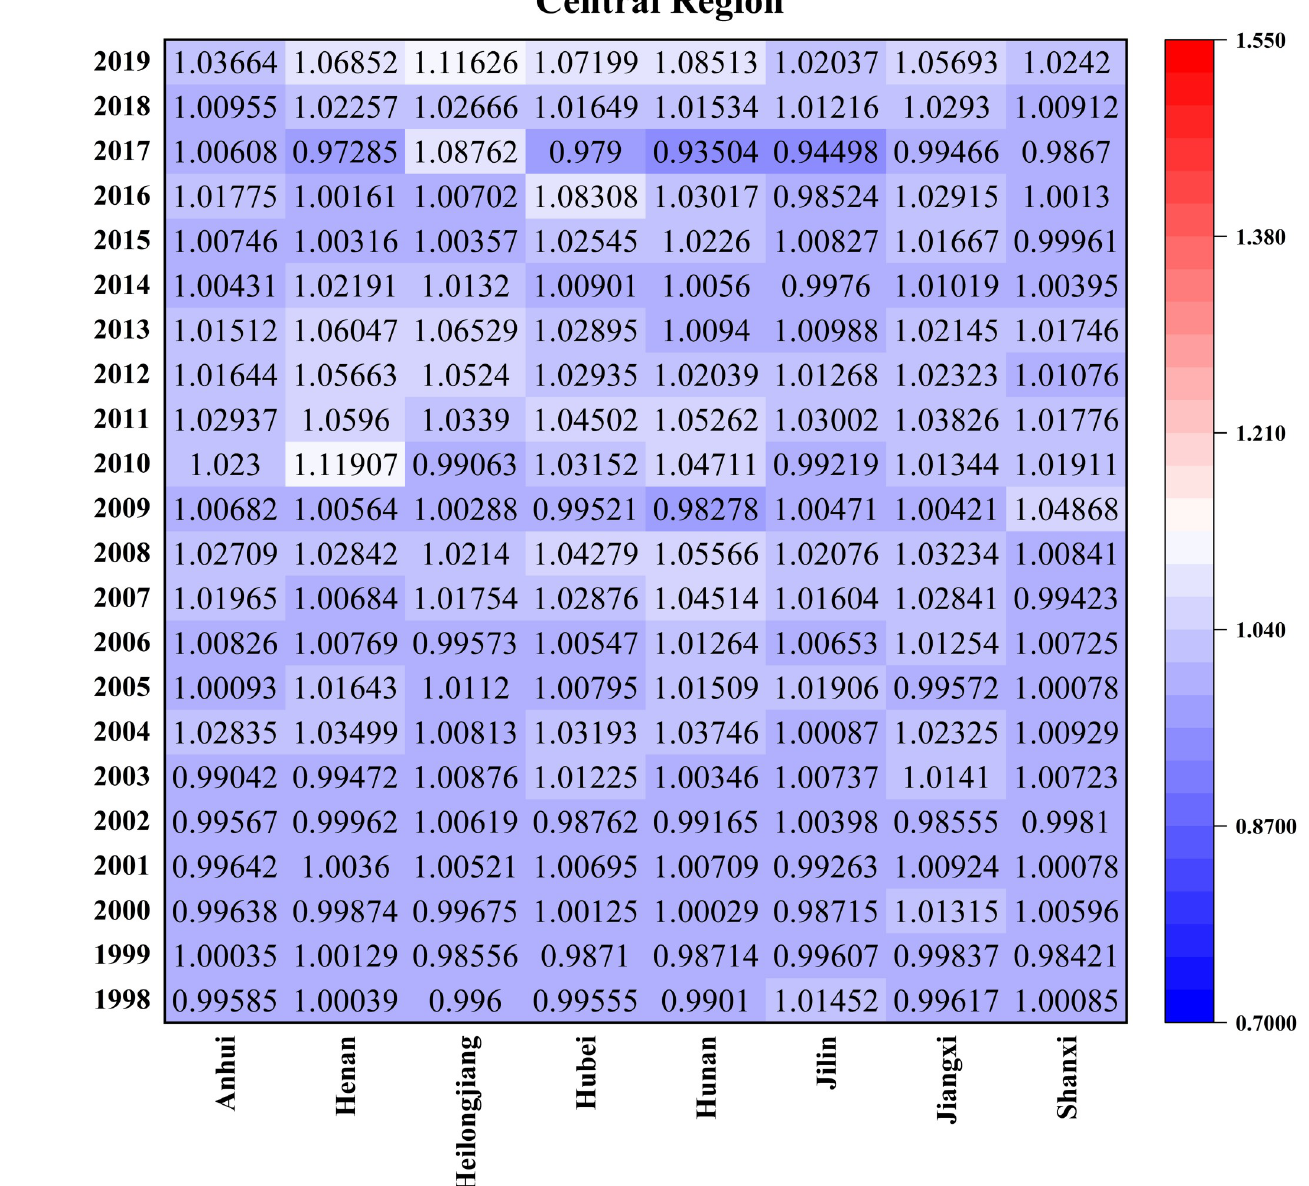
Fig 8. Time variation and average TGRs of GATFP in the central